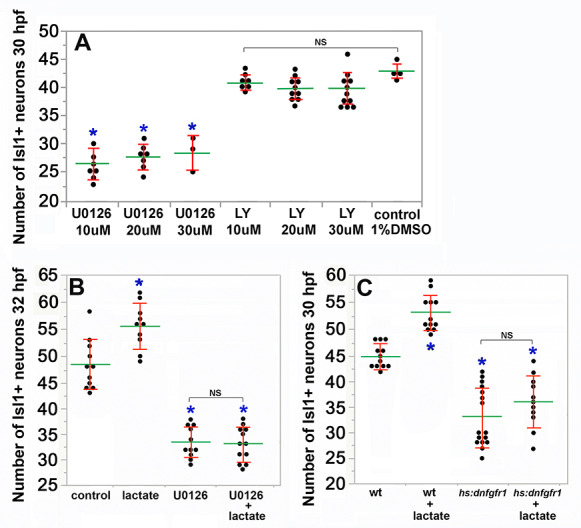
Effects of altering MAPK/Erk, lactate and Fgf on SAG development.(A–C) Mean and standard deviation of the number of Isl1+ SAG neurons. (A) The number of Isl1+ SAG neurons at 30 hpf in embryos treated with MEK inhibitor U0126 or PI3K inhibitor LY294002 (LY) at the indicated concentrations. (B). The number of Isl1+ SAG neurons at 32 hpf in embryos treated with 6.7 mM lactate and/or 20 uM U0126 from 14 hpf. All embryos were incubated at pH 6.2. (C) The number of Isl1+ SAG neurons at 30 hpf in embryos treated with 6.7 mM lactate beginning at 14 hpf as indicated. All embryos were incubated at pH6.2 and heat shocked at 37°C for 30 min at 16 hpf. NS, no significant difference between groups in brackets. .